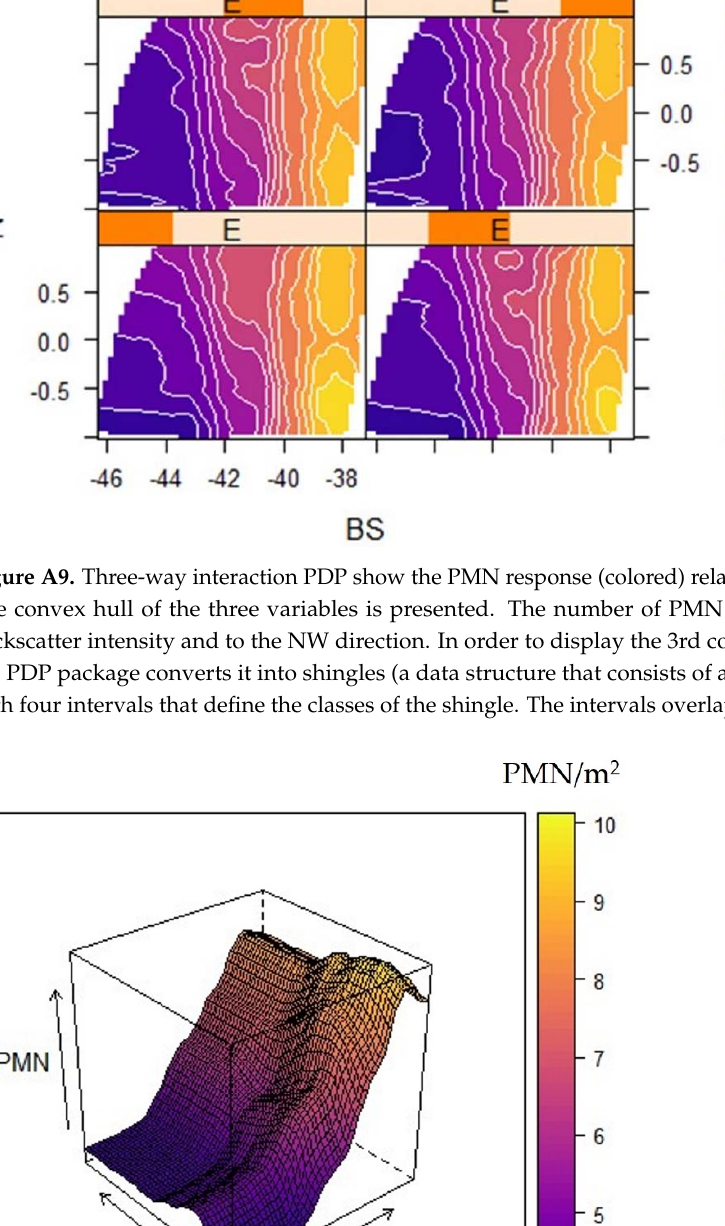
Figure A10. A 3D two-way interaction PDP shows the PMN response (colored surface) related to the BS and BPI100_300.